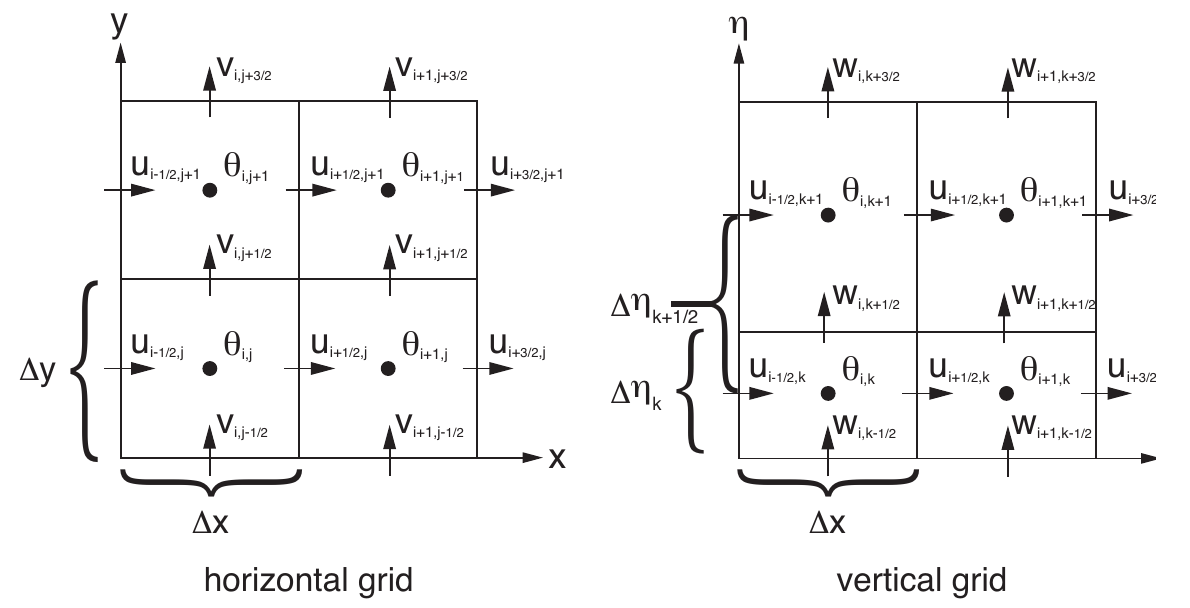
Figure 3.2: Horizontal and vertical grids of the